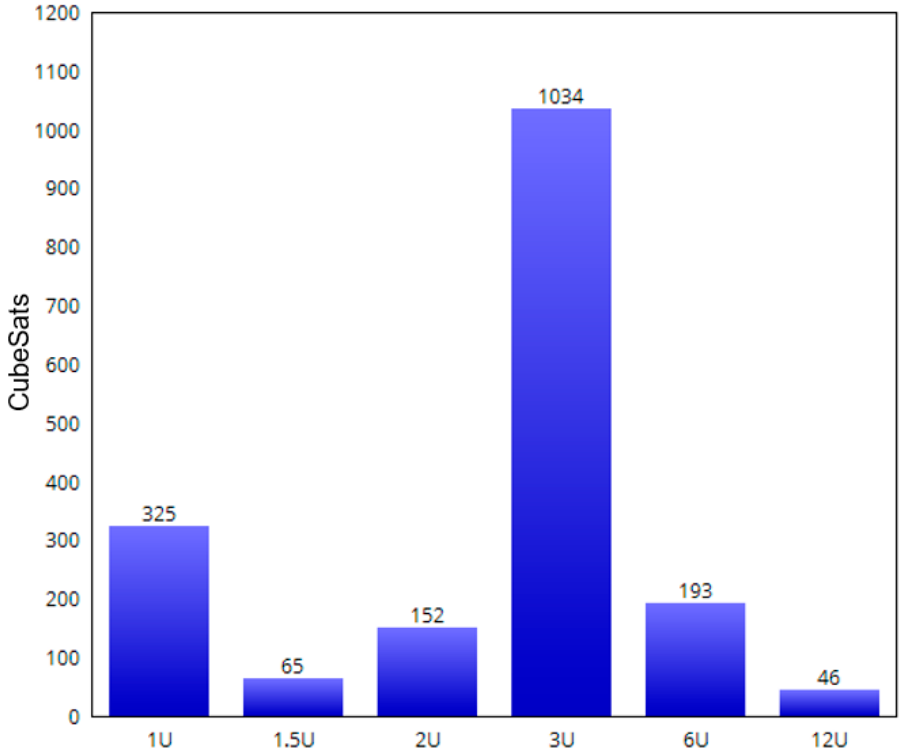
Figure 1. The number of launched CubeSats (based on [4]): Shows the number of launched CubeSats and their types between 2003–2018. The figure includes all CubeSat missions including, government, commercial and educational.